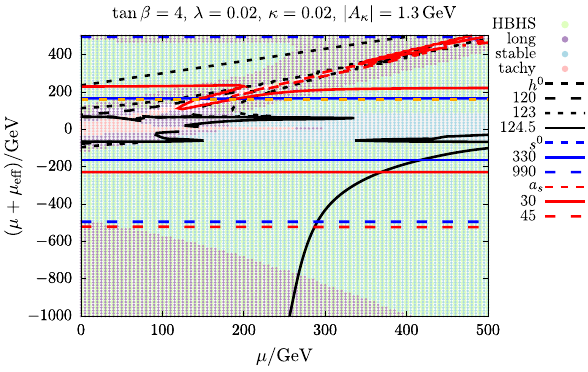
Fig. 12 Vacuum stability analysis for a scenario with small value of λ , butpotentiallylargevaluesof ˜ κ alongthediagonallineof μ eff ≈ 0GeV. The masses of the SM-like Higgs boson and the singlet-like CP -even and -odd states are indicated in black, blue and red, respectively. The green area is allowed by HiggsBounds and HiggsSignals ; with the gray band, the direct exclusion bound on light charginos is shown. Superimposed with orange dashes is the line of constant μ + μ eff = 160GeV, along which Figs.9, 10, 11 are